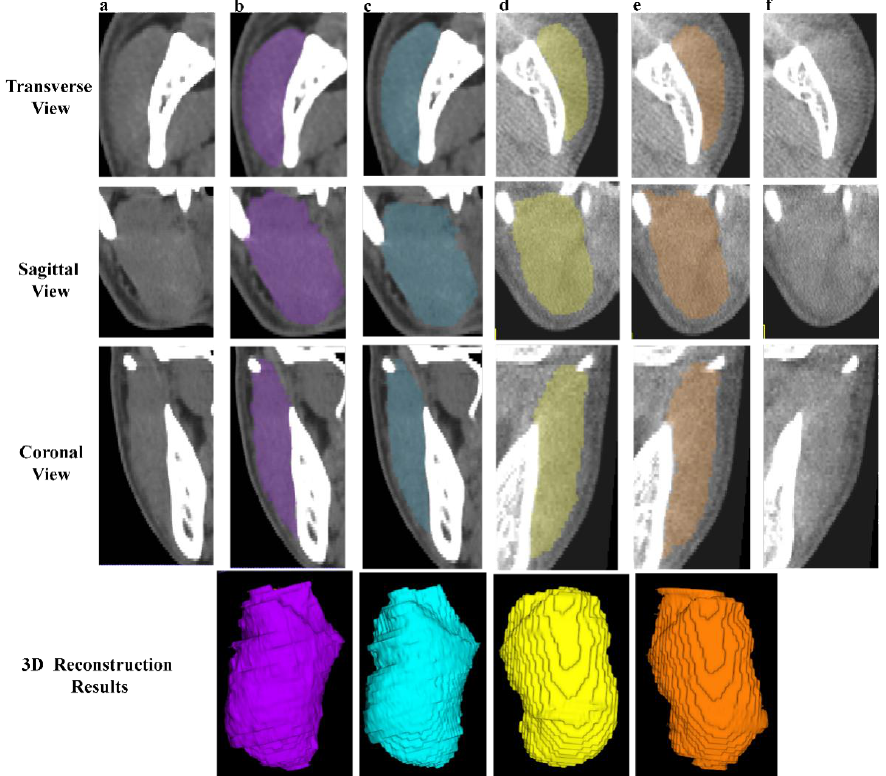
Figure 3. Examples of manual segmentation on CT and CBCT. ( a , f ) The original CT and CBCT im- ages of right and left MM. ( b , e ) The manual annotations and 3D results of right (purple) and left (orange) MM by observer 1. ( c , d ) The manual annotations and 3D reconstruction results of right (blue) and left (yellow) MM by observer 2.